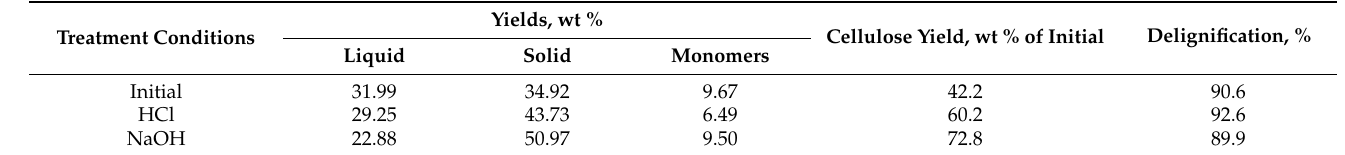
Table 7. Effect of pretreatments of flax shives on the yield of the main products in the followed fractionation process (225° С , 10NiS450).